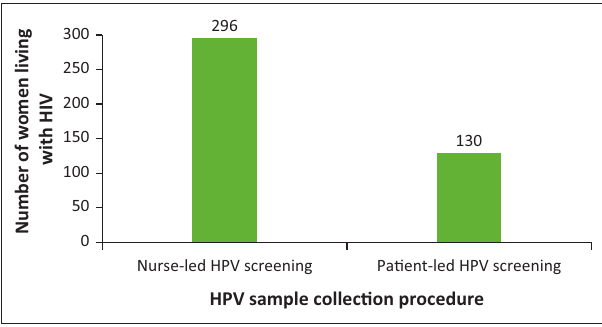
FIGURE 1: Preference for human papilloma virus sample collection procedure among women living with HIV at a rural HIV clinic.